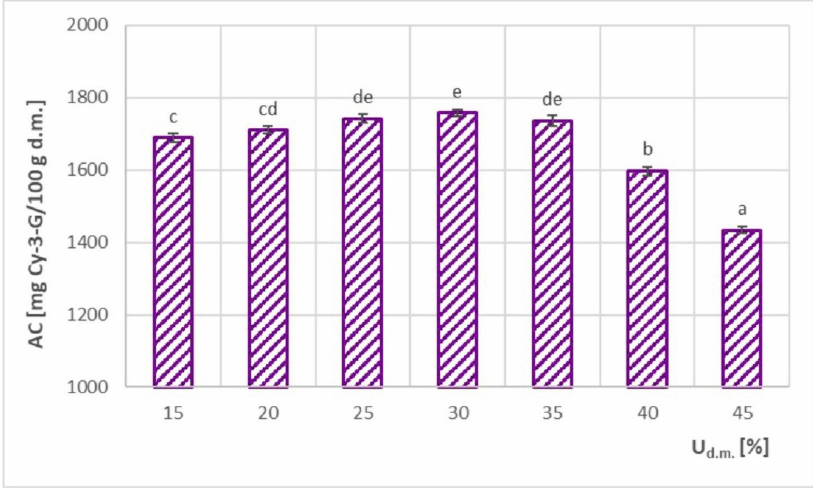
Figure 12. Anthocyanin content (AC) in spray-dried chokeberry juice with different dry matter content in the feed solution (U d.m. ); (a, b, c, d, e — different letters show significant differences between mean values ( p ≤ 0.05)).